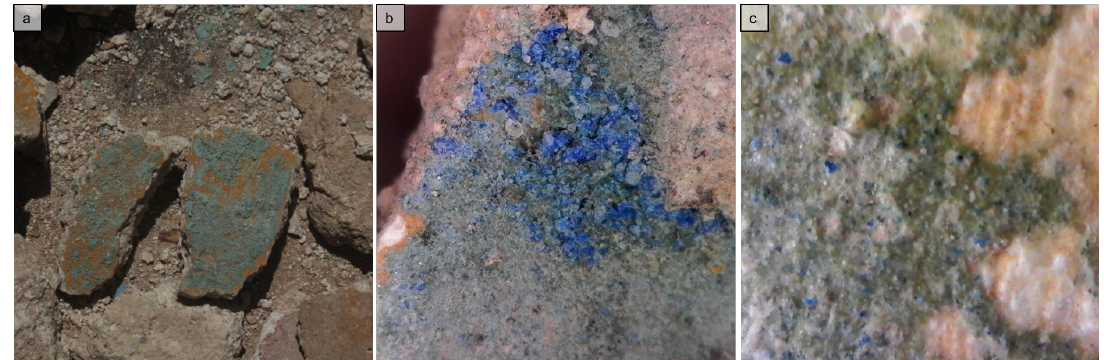
Figure 20. ( a , b ) Fragments recovered from the House of Orpheus (B); ( c ) photomicrograph (250 × ) from Tomb 3882